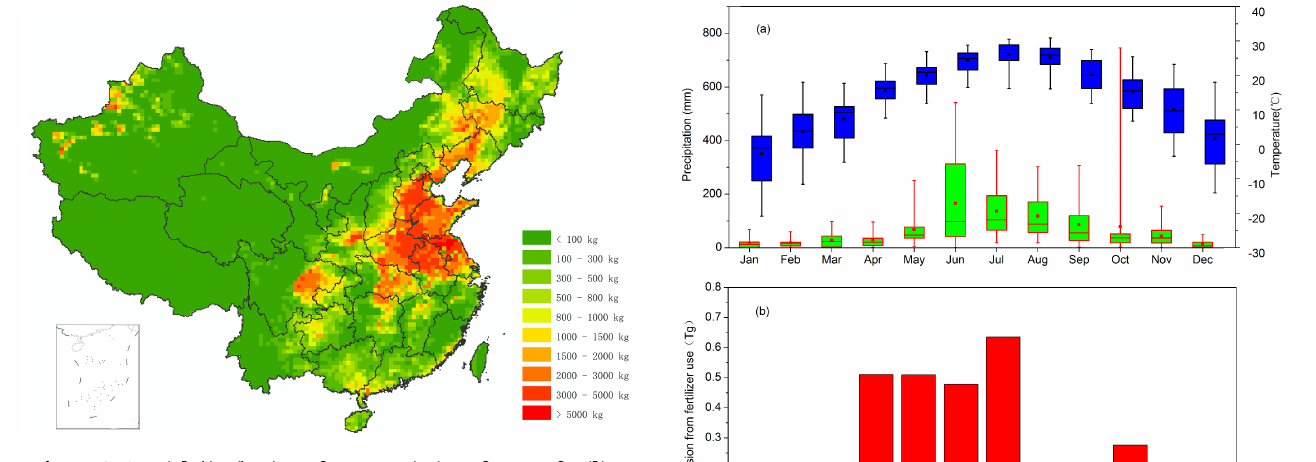
Figure 6. Spatial distribution of NH 3 emissions from N fertilizer use in 36km × 36km grid cell (kgyr − 1 ). The small insert repre- sents the South China Sea and its islands.